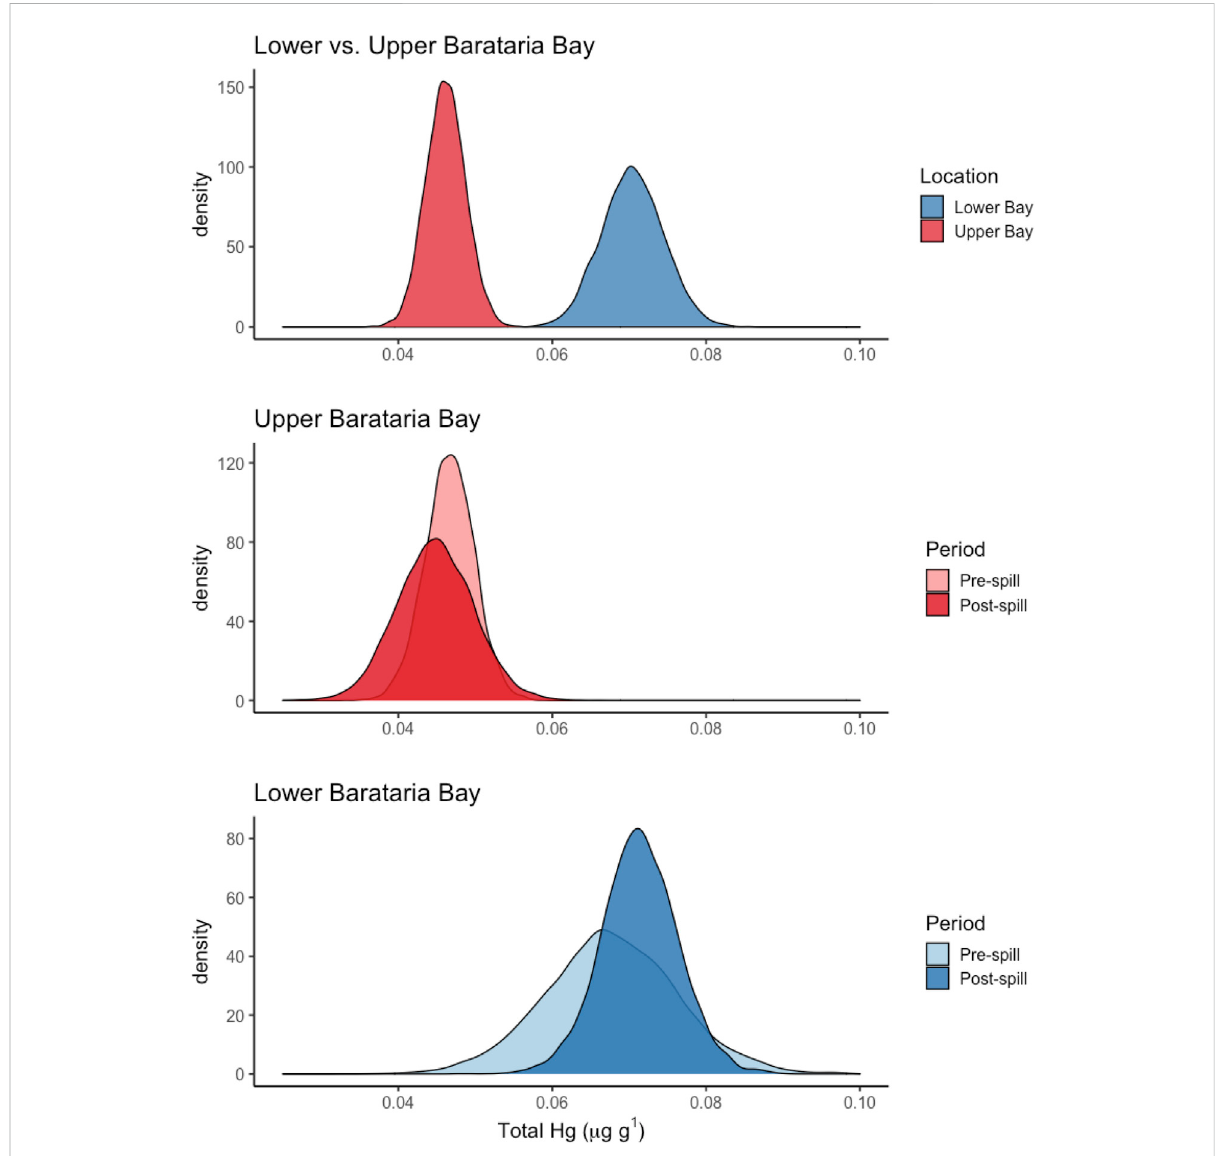
FIGURE 2 Posterior distributions estimated from Bayesian t-tests to compare THg dry wt. concentrations in oysters at two different locations in Barataria Bay before (pre-spill) and after (post-spill) the 2010 Deepwater Horizon oil